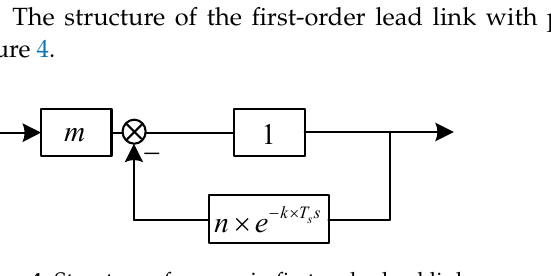
( b ) ( c ) Figure 5. Bode diagrams of first-order lead link under different coefficient changes: ( a ) Bode diagrams of first-order lead- ing links under different values of m ; ( b ) Bode diagrams of first-order leading links under different values of n ; ( c ) Bode diagrams of first-order leading links under different values of k. It can be seen from Figure 5a that when the other coefficients remain unchanged, the change of the coefficient m only changes the gain of the first-order lead link and has no effect on the phase. With the increase of the coefficient m , the gain of the first-order lead link gradually increases. Therefore, the coefficient m can play the role of first-order lead link gain correction. It can be seen from Figure 5b that when m = 1 + n is satisfied, the change of the coef- ficient n can change the compensation effect for the delay—that is, the change of the coef- ficient n will affect the phase size of the first-order lead link. With the gradual increase of the coefficient n , the phase of the first-order lead link also gradually increases. It can be seen from Figure 5c that no matter how the coefficients change, the first- order lead link will always have phase jumps and gain spikes at a certain frequency in the